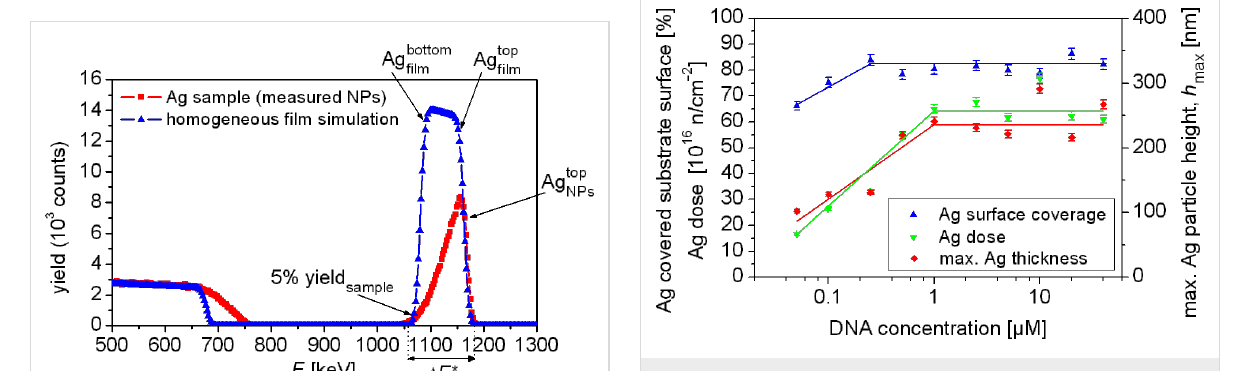
Figure 8: Surface coverage of silver (blue triangles) and absolute number of silver atoms (green circles), both belonging to the left ordinate, as well as the maximum height of the silver nanoparticles assuming the silver bulk density for the nanoparticles (red squares; belonging to right ordinate) of EGNP films on silicon in dependence on the DNA concentration, determined by means of RBS measurements. The reaction time was always 5 min. The lines are only a guide for the